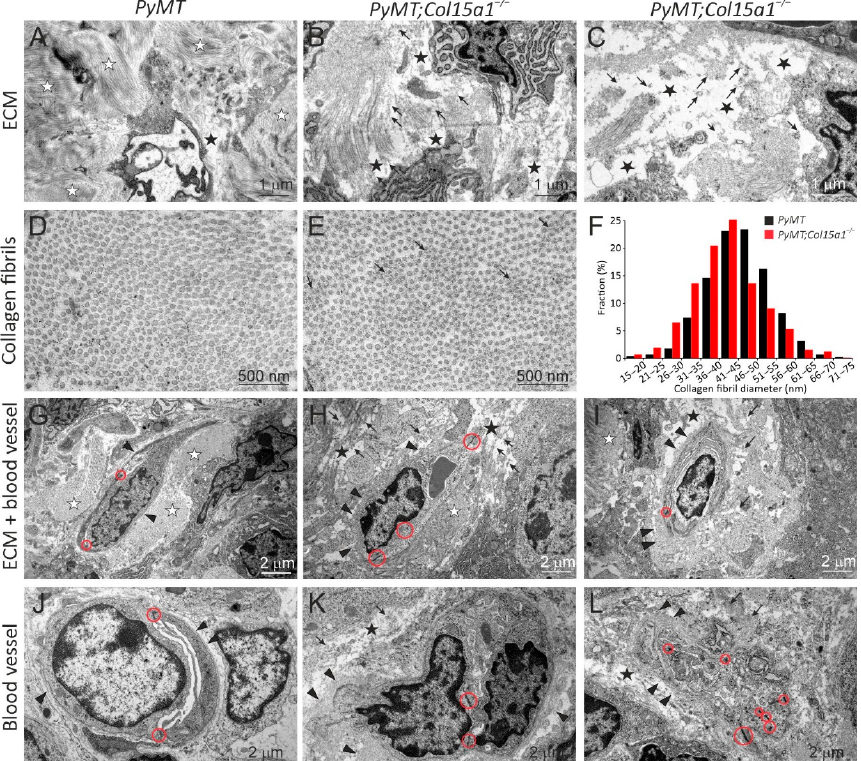
Figure 3. Ultrastructural analysis of mammary tumour stroma. Transmission electron microscopy shows that, in the PyMT control tumours ( A , G ), the stromal ECM is filled with clearly outlined collagen fibres (white stars), whereas, in the PyMT ; Col15a1 ‒ / ‒ tumours ( B , C , H , I ), the ECM appear sparse (black stars), with accumulations of non-fibrillar protein aggregates (arrows). These protein aggregates accumulated also within collagen fibres in the PyMT ; Col15a1 ‒ / ‒ tumours ( E ). The collagen fibril diameter in PyMT ; Col15a1 ‒ / ‒ tumours is slightly decreased and variable ( E , F ) when compared to PyMT control tumours ( D , F ). For calculating fibril diameter fractions, 893–1032 fibrils/genotype and 121–265 fibrils/tumour sample were measured. The capillary BM (arrowheads) is well defined in the PyMT control tumours ( G , J ) but thickened with ECM protein deposits in the PyMT ; Col15a1 ‒ / ‒ tumours ( H , I , K , L ). No obvious difference was found in the endothelial cell–cell junctions (open red circles) in the tumour capillaries between genotypes ( G – L ). Three mammary tumours from two mice of both genotypes (N = 6 + 6), harvested at the age of 10 weeks, were analysed by electron microscopy.